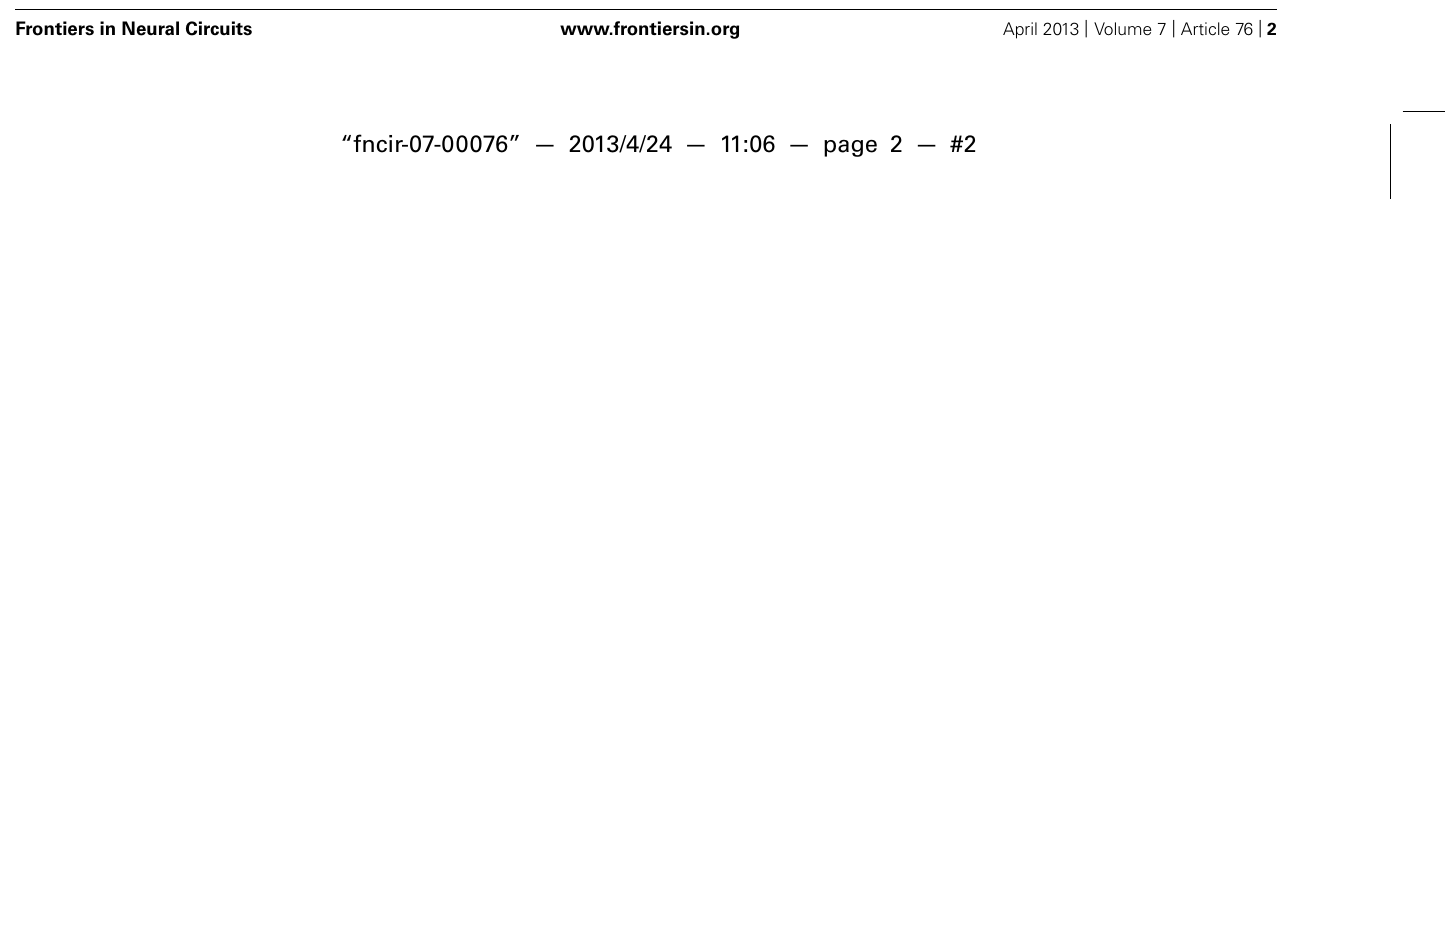
FIGURE 1 | Comparison of brain sizes of common vertebrate neuroscience models. (A) Schematic diagram of the lateral view of adult human, mouse, and zebrafish brains to scale. (B, C) Schematic diagram of the linear organization of major brain regions from olfactory bulb to spinal cord (B) and the dorsal location of telencephalic structures such as the presumptive